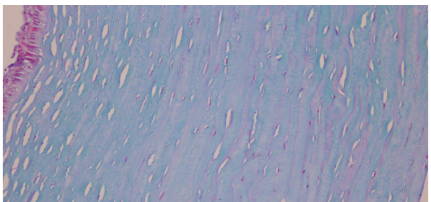
Figure4:Cornealstromasampleinverticalorientationstainedwith blue Alcian.